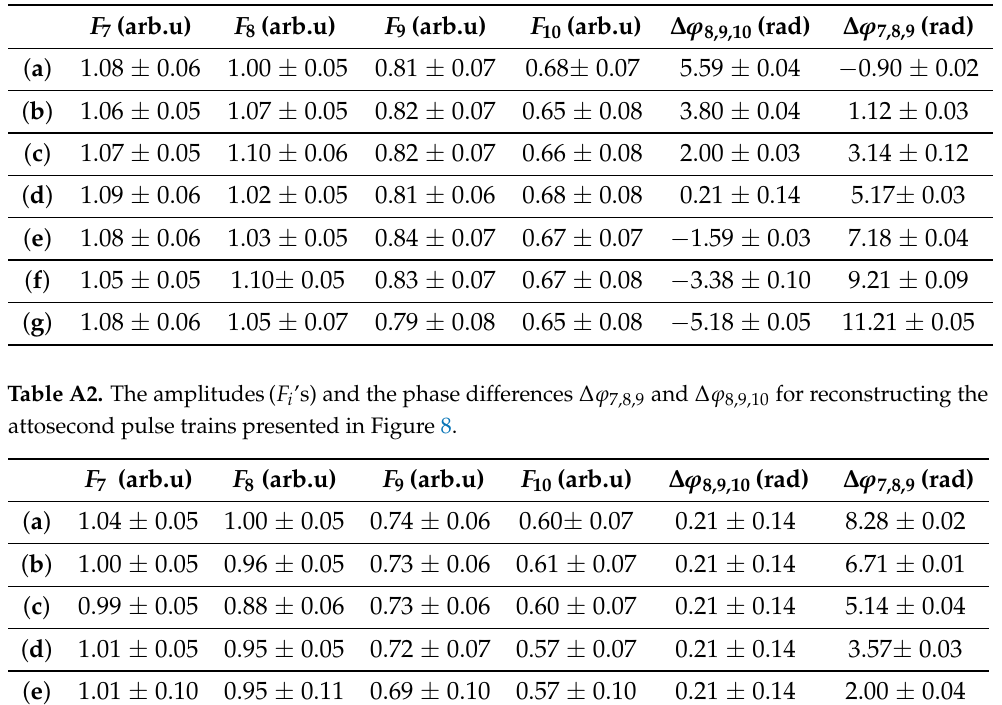
Table A1. The amplitudes( F i ’s) and the phase differences ∆ ϕ 7,8,9 and ∆ ϕ 8,9,10 for reconstructing the attosecond pulse trains presented in Figure 6.